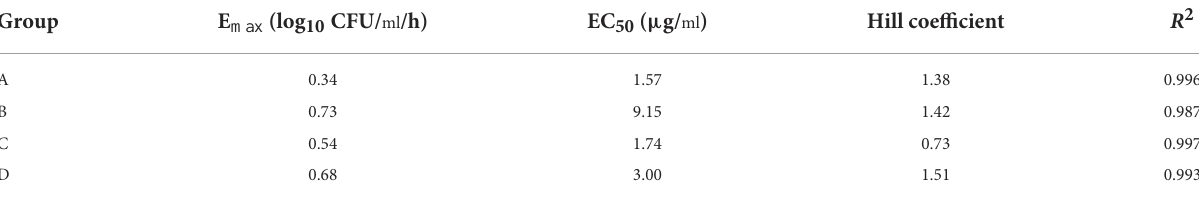
TABLE 2 Estimation of the kill-rate parameter derived from the E max model which fitted the data from the in vitro static time–kill curve at an interval of 0–9h. Group E max (log 10 CFU/ ml /h) EC 50 ( µ g/ ml ) Hill coefficient R